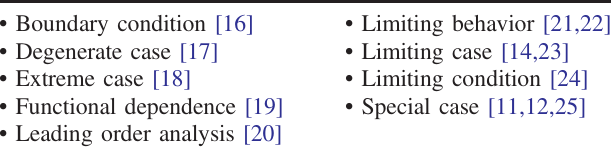
TABLE I. Related limiting case analysis terms in the